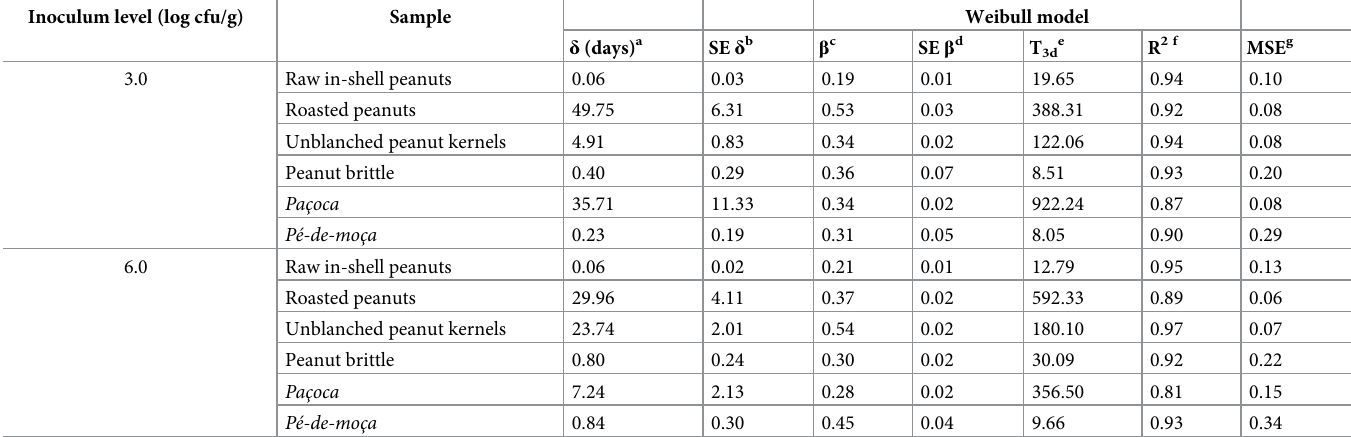
Table 2. Parameters of the Weibull model fitted for Salmonella Typhimurium ATCC 14028 survival in peanut-based products with two inoculum levels during a 420 days storage period at 28 ± 1˚C. Inoculum level (log